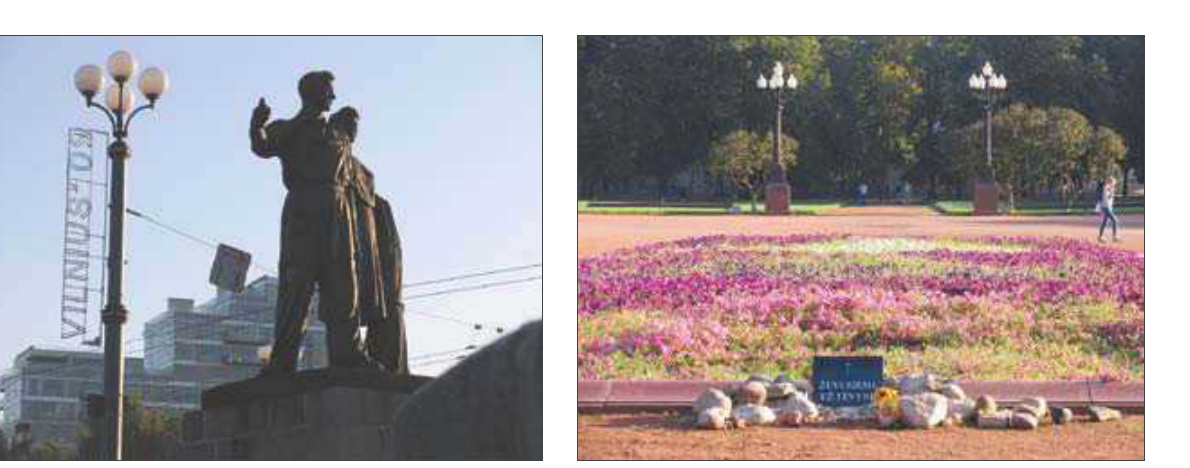
Fig. 7. Sculptures of Green bridge